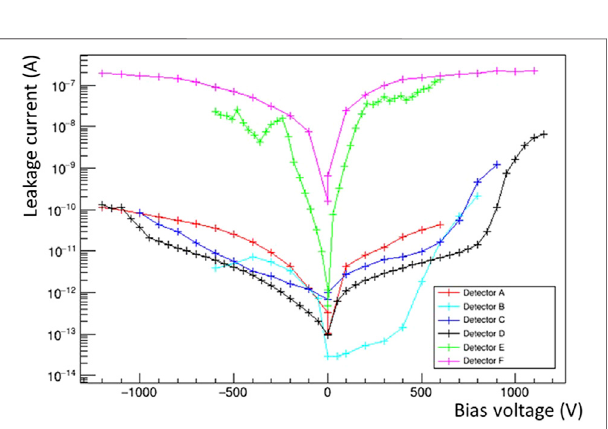
FIGURE 2 | Measurement of the leakage current versus the bias voltage for various diamond samples.